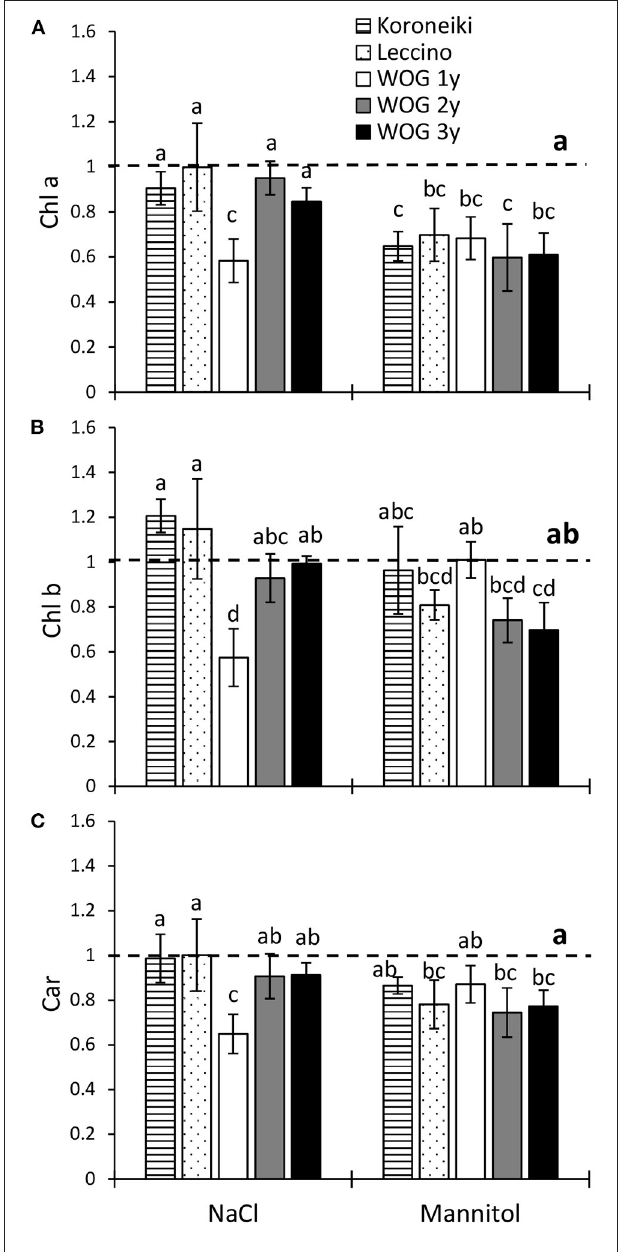
FIGURE 2 | The relative contents of (A) chlorophyll a (Chl a ), (B) chlorophyll b (Chl b ), and (C) carotenoids (Car) in leaves of olive after exposure to NaCl or mannitol. Controls are normalized to the value 1. Columns marked with different letters are statistically significantly different ( p ≤ 0.05). The bars represent mean ± SD, n = 3. Raw data are presented in Supplementary Table 3 . SD, standard deviation.